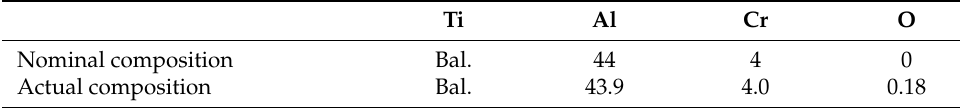
Figure 1. An as-built 44-4 alloy rod fabricated by EBM ( a ) and schematic drawings of the rod and the specimen configuration for tensile tests ( b ). Table 1. Chemical composition of the 44-4 alloy rods fabricated by